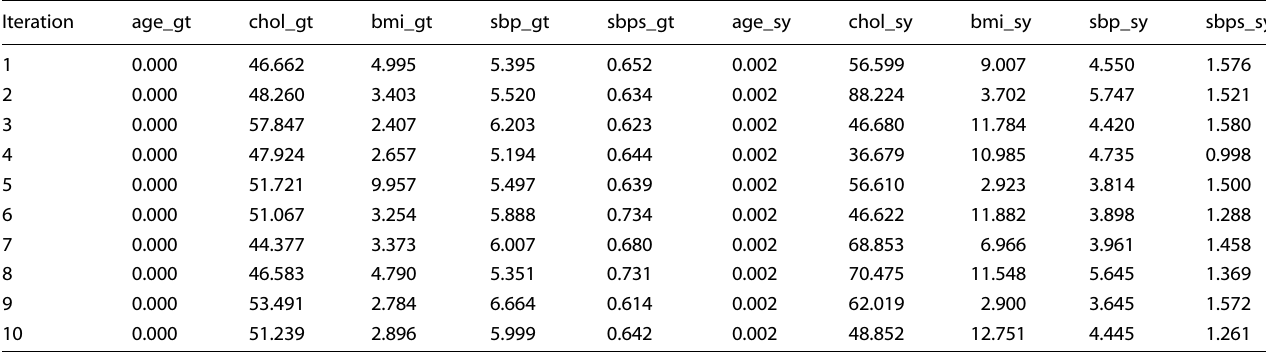
Table 3. The mean squared D KL ð GT i jj GT n i Þ ( n ∈ {1 … 10}) of each variable ending with “ gt ” and the mean squared D KL ð GT m i Þ SY n i each variable ending with “ sy ” .